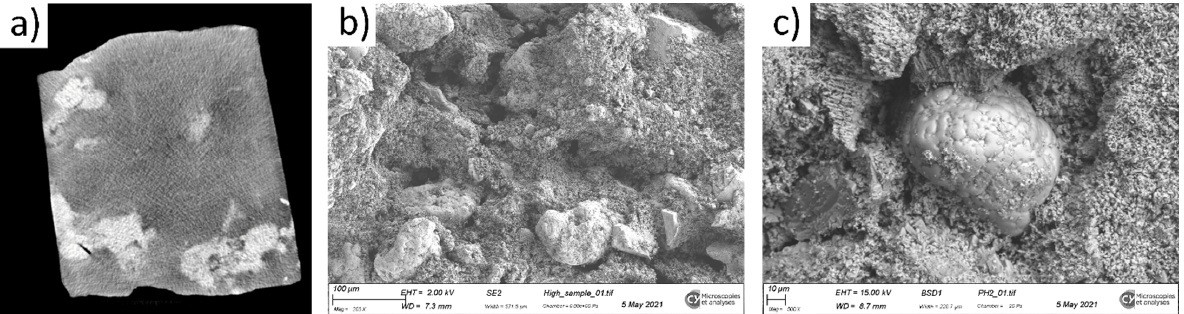
Figure 1. ( a ) Density map in a 16 × 18 cm block of Ciply Chalk obtained by CT scan. ( b ) SEM micrograph showing the heterogeneous microstructure in Ciply Chalk. ( c ) Close view of a brain-like nodule made of fluorapatite.